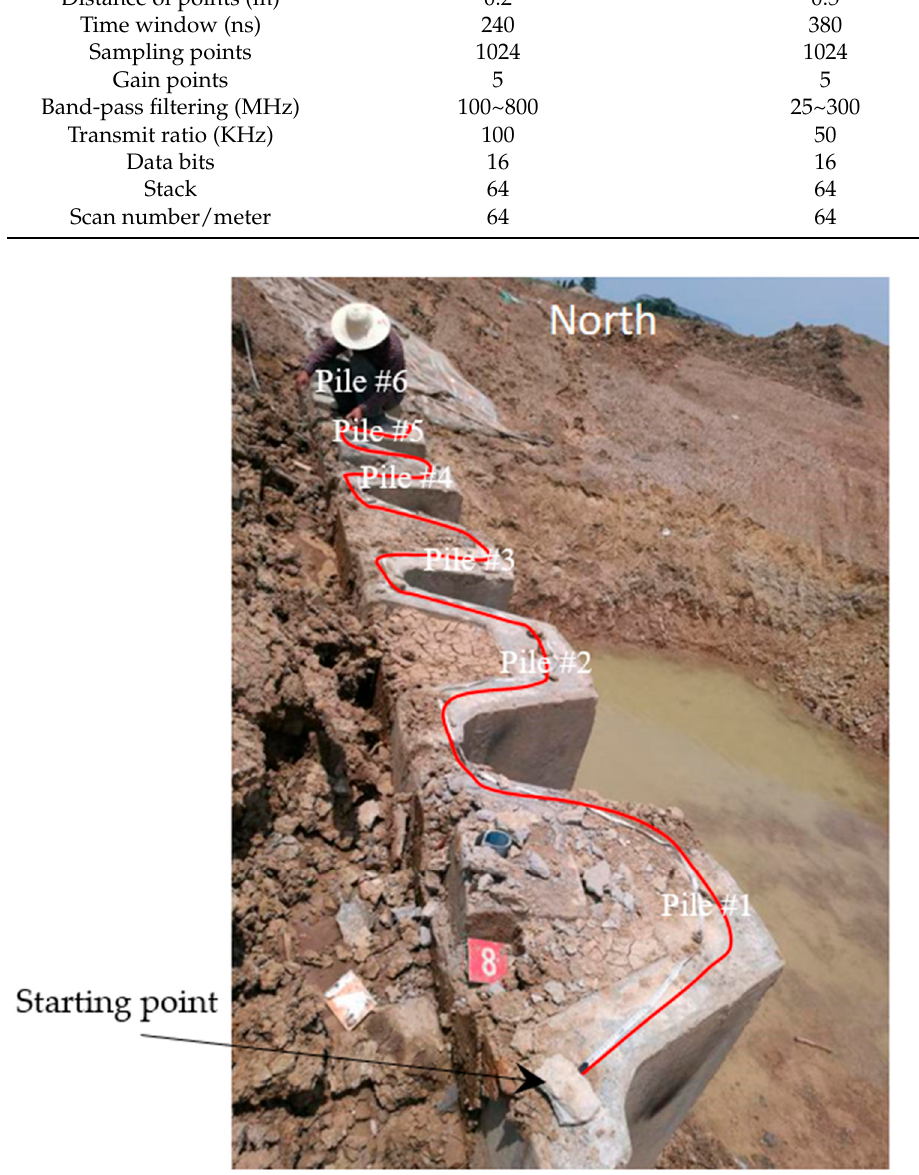
Figure 5. GPR survey line arrangement diagram.